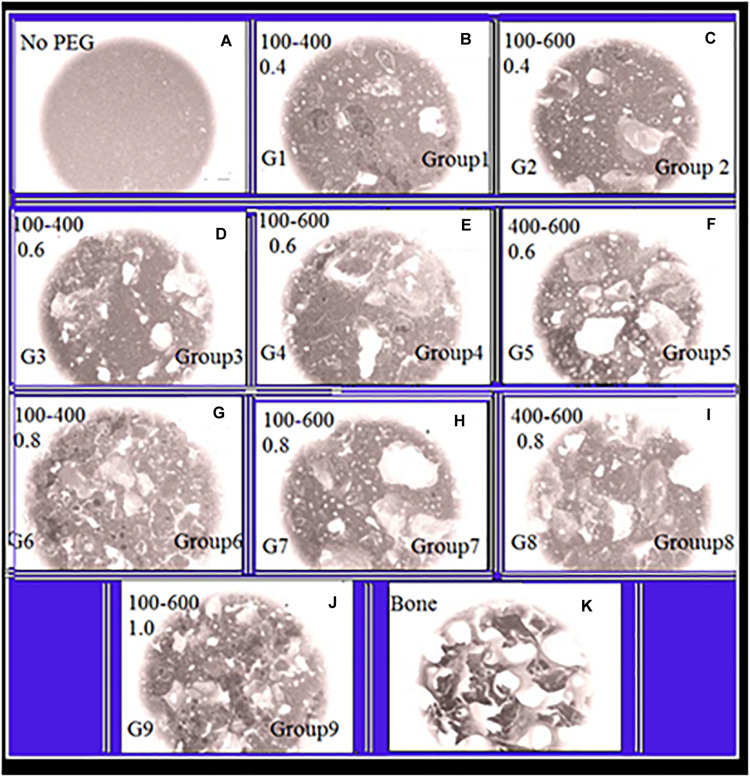
Panels (A–K) are SEM-illustrations of macroporous scaffold with different amounts of PEGPs as indicated below: (A) Reference sample with zero PEGPs, Group1 (G1), (B) 0.4 weight-ratio (WR) of PEGPs with 100–400 μm diameter PEGPs. (C) (G-2): 0.4 WR of PEGPs with 100–600 μm diameter PEGPs. (D) (G-3): 0.6 WR of PEGPs with 100–400 μm diameter PEGPs. (E) (G-4): 0.6 WR of PEGPs with 100–600 μm diameter PEGPs. (F) (G-5): 0.6 WR of PEGPs with 400–600 μm diameter PEGPs. (G) (G-6): 0.8 WR of PEGPs with 100–400 μm diameter PEGPs. (H) (G-7): 0.8 WR of PEGPs with 100–600 μm diameter PEGPs. (I) C – (G-8): 0.8 WR of PEGPs with 400–600 μm diameter PEGPs. (J) (G-9): 1.0 WR of PEGPs with 100–600 μm diameter PEGPs. (K) Real decellularized/bone-scaffold.